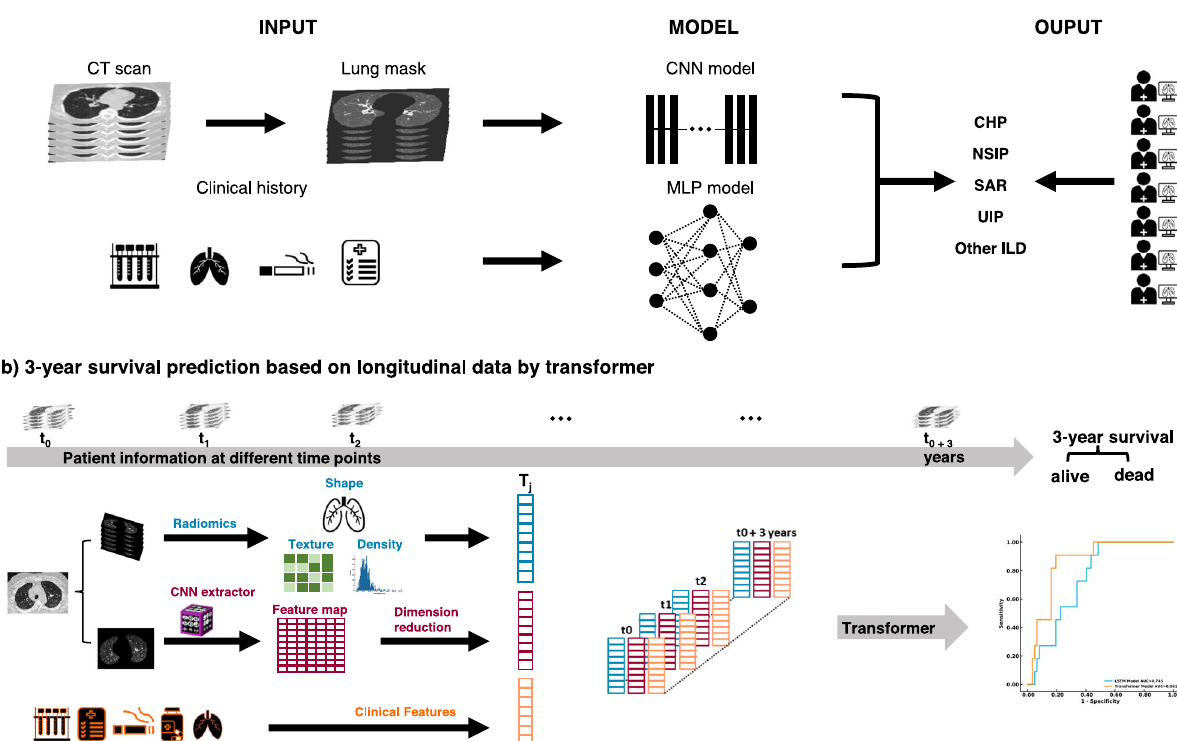
Fig.1|Overviewoftheframework. TheILDclassi fi cationmodelwasgeneratedto predict the subtype of ILD for each patient based on CT scans of the chest and clinical information. A survival rate prediction AI model was generated based on the longitudinal data of each patient. a For the classi fi cation of ILD, we